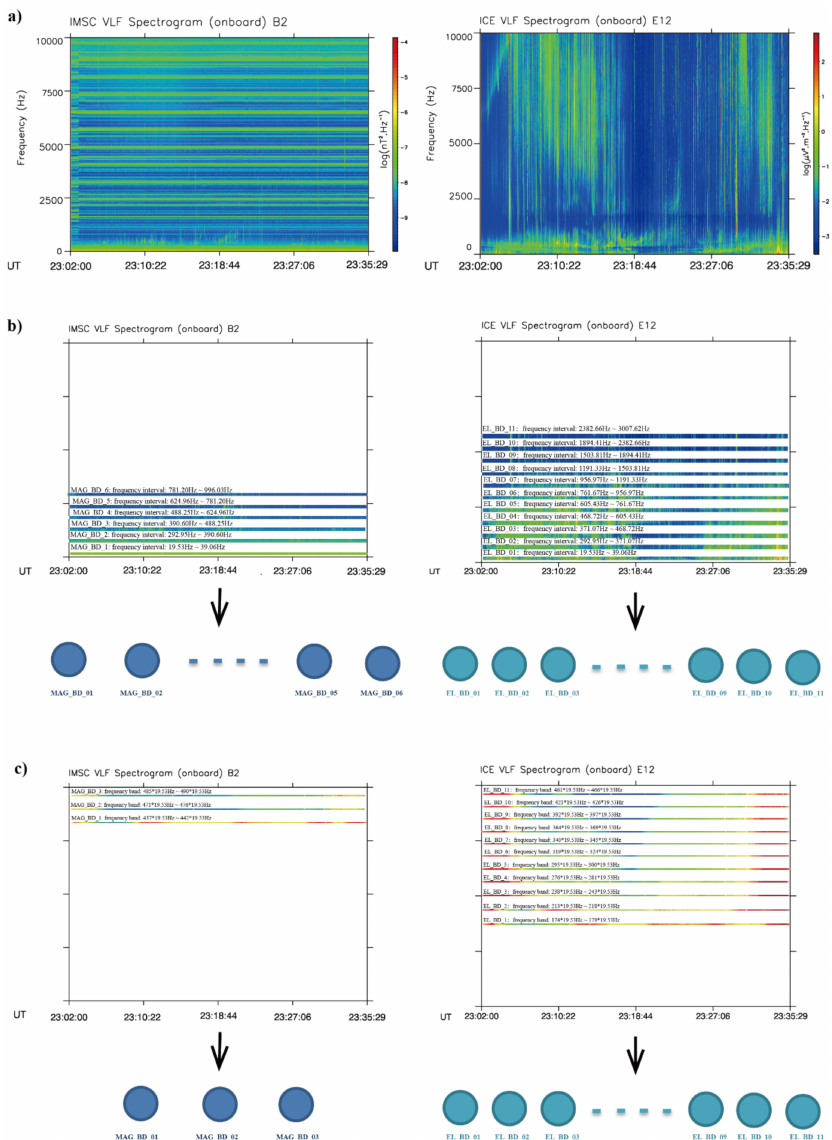
Figure 1. ( a ) Original power spectra of electric field (right pane) and magnetic field (left pane), the frequency range of our analysis is limited to below 10 kHz. ( b ) Processing to 11 and 6 frequency bands for the electric and magnetic field, respectively, the frequency range is limited to below 3 kHz with instrument champ electrique (ICE) and below 1kHz with instrument magnetic search coil (IMSC). ( c ) Processing to 11 and 3 frequency bands for the electric field (3–10 kHz) and magnetic field (8–10 kHz),